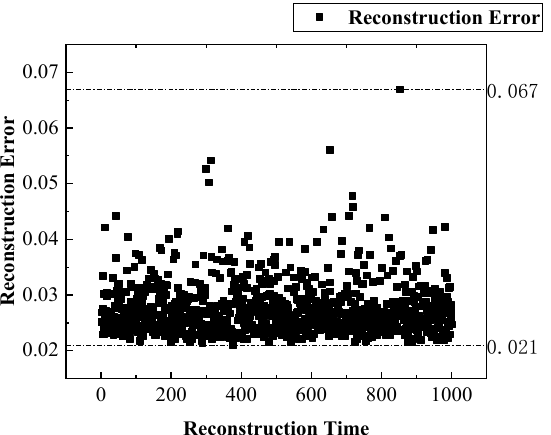
Figure 3. 1000 reconstruction errors of condition 5.